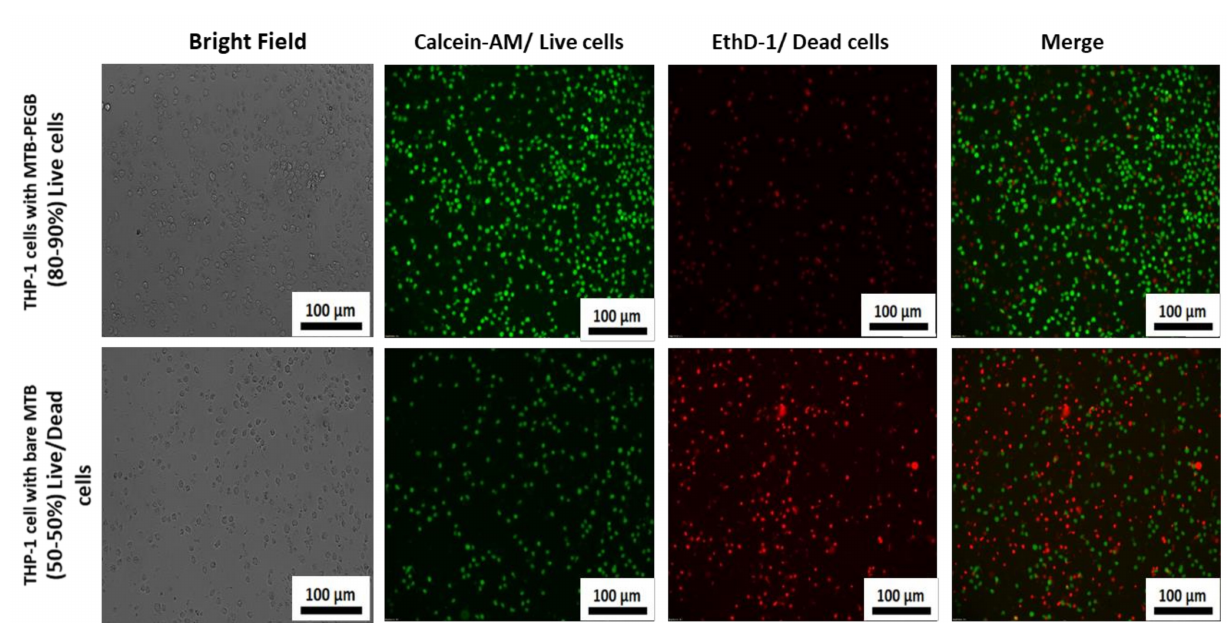
Figure 6. Bright-field and fluorescence microscopic images of live/dead assay: live/dead cell viability assay of THP-1 cells treated with bare MTB and the MTB/PEG–biotin complex. The cells were incubated for 24 h and then stained with a double-staining kit (calcein-AM and ethidium dimer-1). The live and dead cells exhibited green and red fluorescence, respectively. THP-1 cells treated with bare MTB showed 50% live cells, whereas cells treated with the MTB/PEG–biotin complex displayed 80–90% live